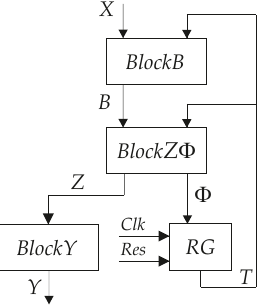
Figure 4. Structural diagram of Mealy FSM U 2